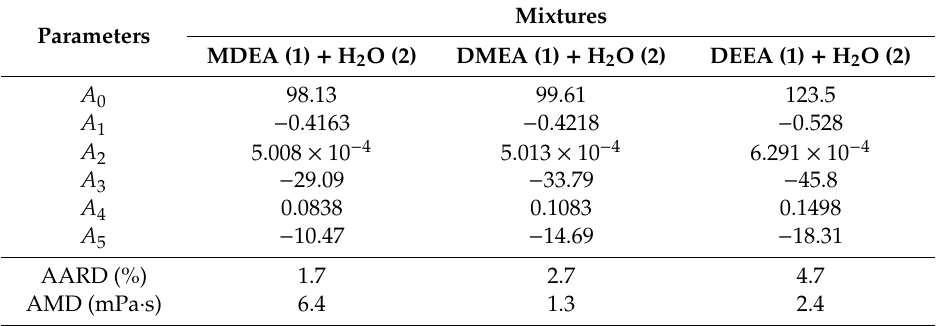
Table 7. Coe ffi cients ( A i ) for the viscosity deviation ln ( η γ ) of di ff erent aqueous amine mixtures.